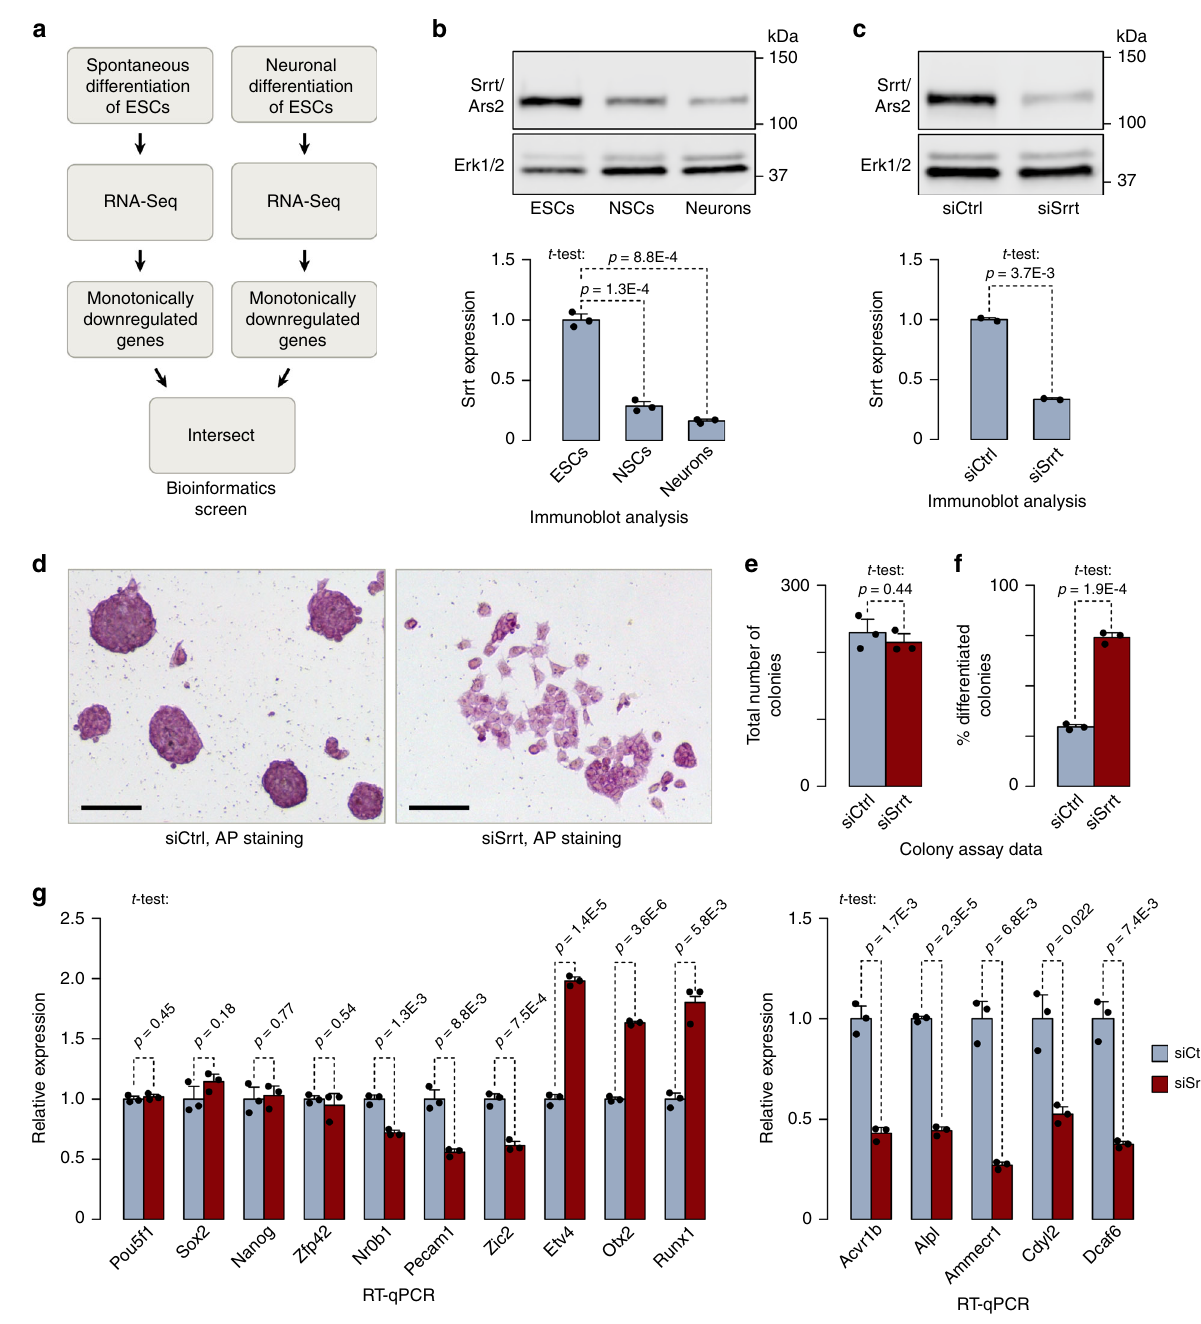
Fig. 1 Srrt is required for mouse ESC maintenance. a Bioinformatics work fl ow used to identify putative regulators of mouse ESC identity. b Top: immunoblot analysis of Srrt expression in mouse ESCs, cortical NSCs, and cortical neurons prepared and cultured in vitro as described 86 . Bottom: Srrt protein expression was quanti fi ed from three independent experiments (mean ± SD) and compared using a two-tailed t -test. c Top: ESCs were transfected with an Srrt-speci fi c siRNA mixture (siSrrt) or a non-targeting control siRNA (siCtrl) and Srrt knockdown ef fi ciency was analyzed by immunoblotting 48 h later. Bottom: the experiment was repeated twice (mean ± SD) and the samples were compared using a two-tailed t -test. b , c Erk1/2 is a lane loading control. d ESCs were transfected with siSrrt as in c and assayed for alkaline phosphatase (AP) activity. Note pronounced changes in morphology of colonies and individual cells and a decrease in the AP staining intensity. Scale bar, 100 μ m. e , f Colony assay data showing that e siSrrt does not change the overall number of ESC colonies but f signi fi cantly increases the fraction of fl attened differentiated colonies compared to siCtrl. The assay was repeated three times (mean ± SD) and analyzed by a two-tailed t -test. g Left: RT-qPCR data showing that, while Srrt knockdown does not change expression of pluripotency markers Pou5f1, Sox2, Nanog, and Zfp42/Rex1, it leads to signi fi cant downregulation of Nr0b1, Pecam1, and Zic2 and upregulation of early differentiation markers Etv4, Otx2, and Runx1 (refs. 39,43,87 ). Right: targets strongly downregulated by siSrrt include additional examples of known ESC markers and factors with possible regulatory roles in proliferating cells 43 – 47 . All RT-qPCR experiments were done at least in triplicate and shown as mean ± SD. The expression levels in siCtrl-treated samples were set to 1, and the p values were calculated using a two-tailed t -test. Source data are provided as a Source Data fi